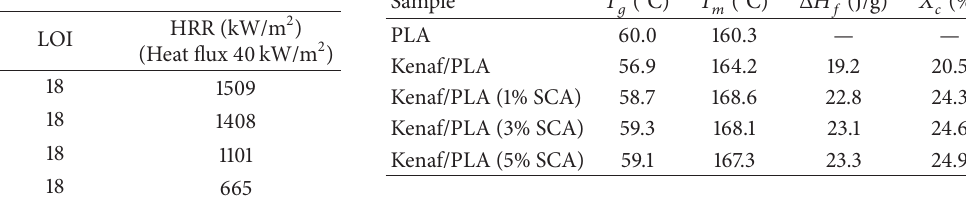
Table 2: Limiting oxygen index (LOI) and heat release rate (HRR) of some polymers [58].